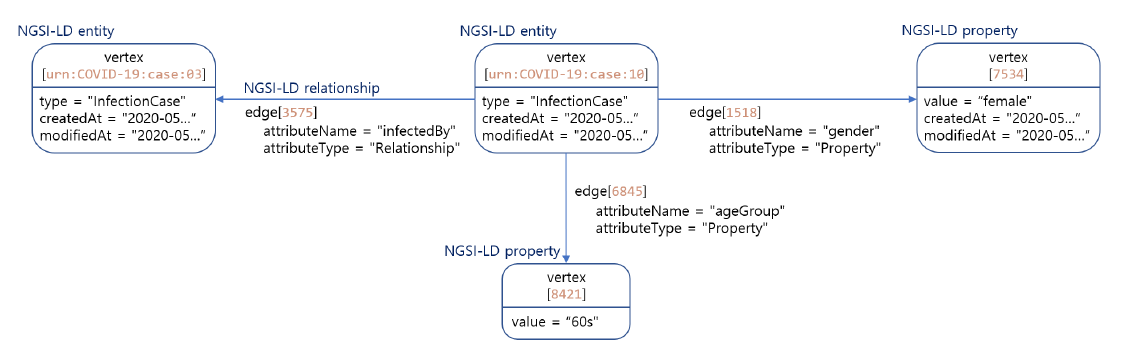
Figure 8. Mapping Infection Entity to Graph